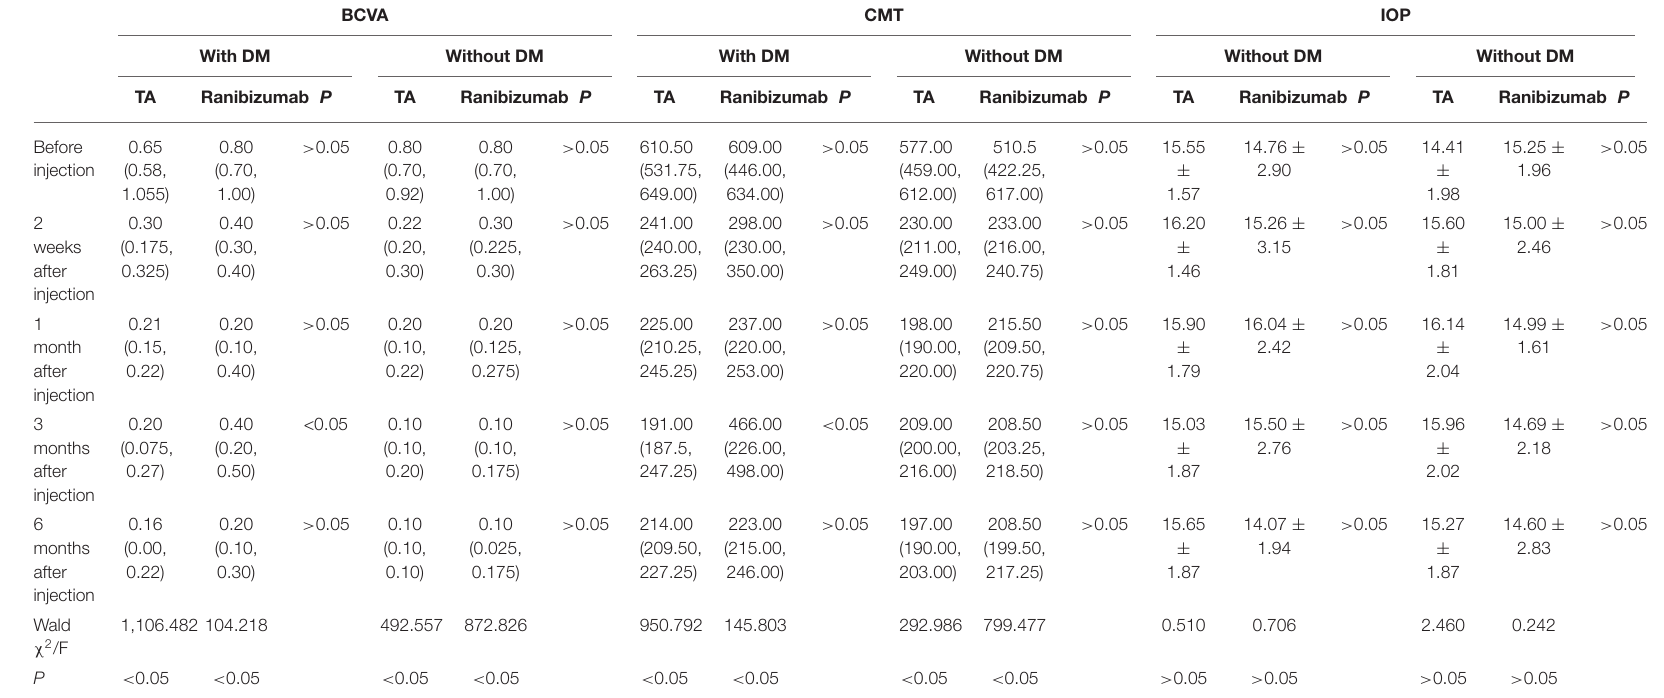
TABLE 2 | Stratified analysis for patients with or without diabetes mellitus (DM) analysis in BCVA, CMT, and